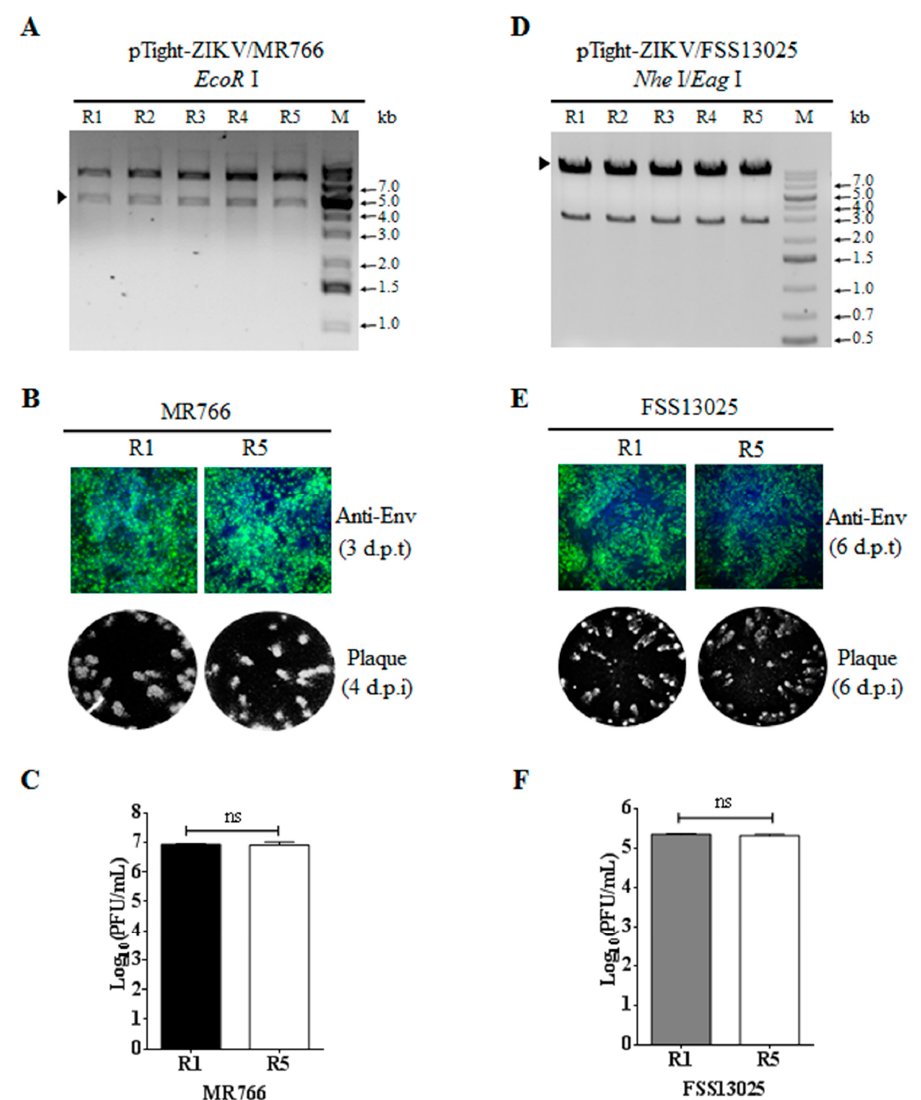
Figure 6. Determination of genetic stability of infectious ZIKV cDNA clones in E. coli . ( A ) Analysis of the pTight-ZIKV/MR766 DNA stability by EcoR I digestion. The pTight-ZIKV/MR766 plasmid